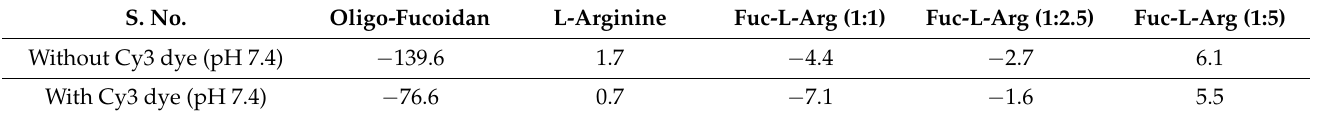
Table 2. Zeta potential charge measurement without and with the Cy3 dye complex.